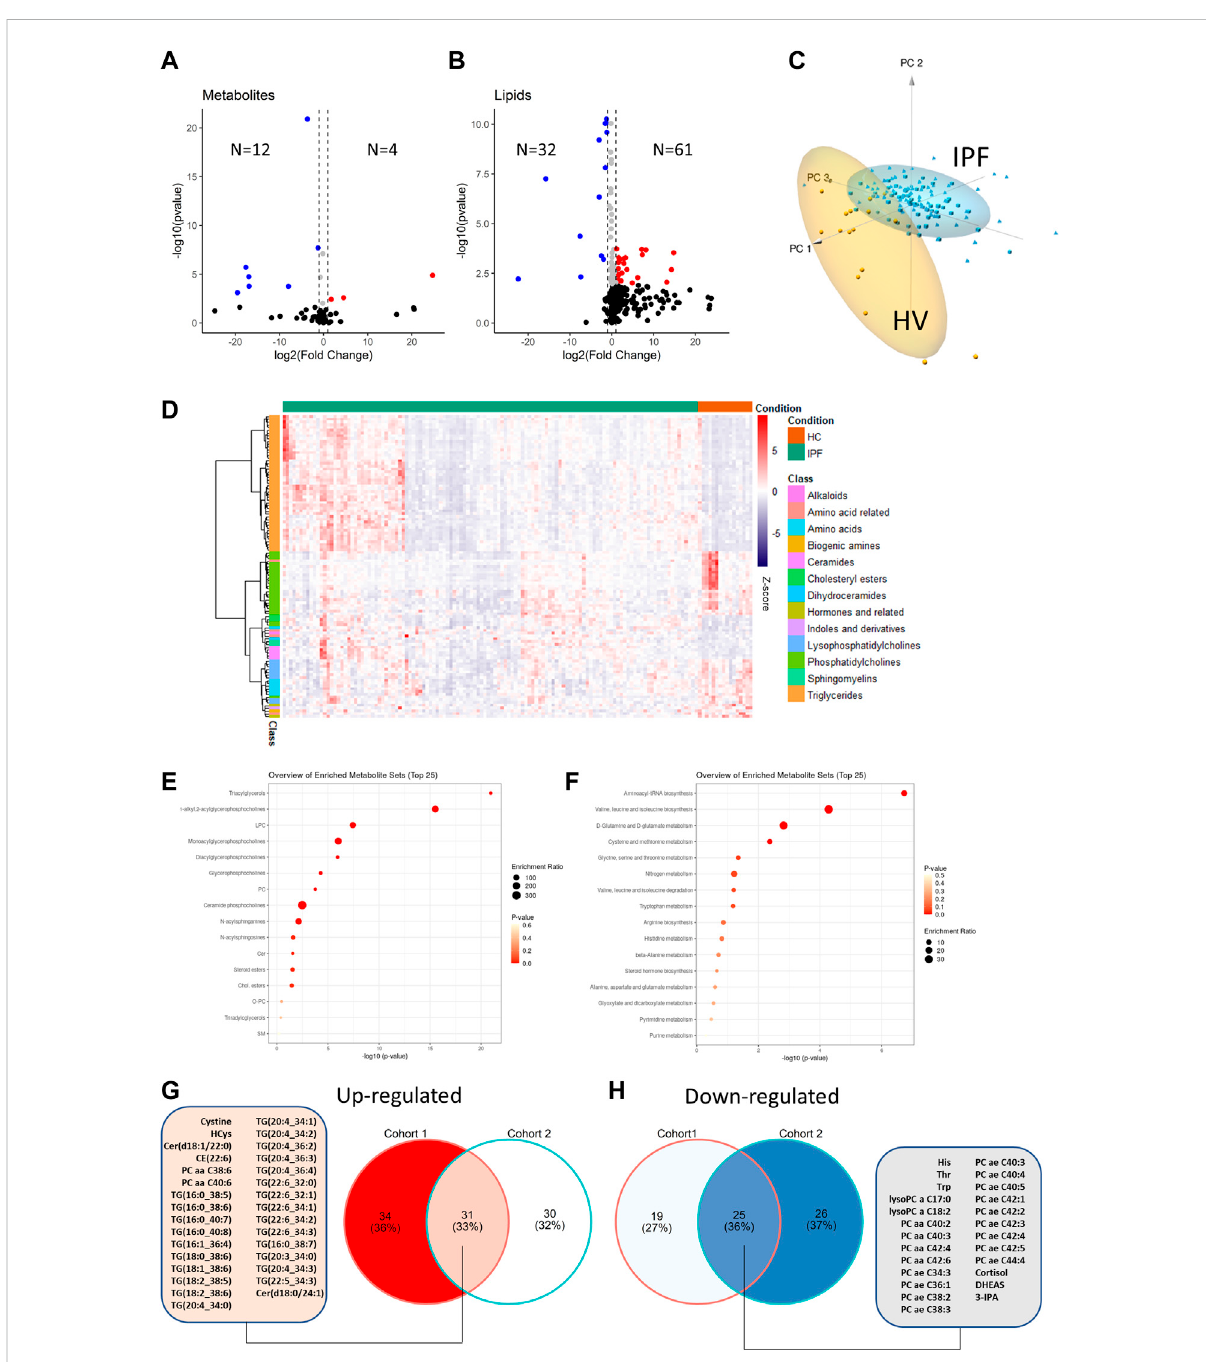
FIGURE 2 Comparison of metabolite differential abundance between patients with idiopathic pulmonary fi brosis and healthy volunteers. Log2-Fold changes were plotted against -log10 ( p -value) of cohort 1 vs. IPF for small molecules (A) and lipids (B) as volcano-plots with numbers of signi fi cantly (FDR < 0.05) up or down-regulated analytes indicated. Deregulated analytes were scaled and plotted as a 3 days principal component analysis with high lighting of IPF vs. healthy volunteers (HV) clusters (C) . De-regulated analytes are plotted as a heatmap with hierarchical clustering of analytes (row-wise) and visualization of abundance by Z-score (D) . KEGG IDs (small molecules) or compound names (lipids) were analyzed for pathway enrichment with resulting enrichment ratios and p -values plotted for small molecule pathways (E) and lipid pathways (F) . The overlap between de-regulated analytes from the IPF cohort 1 and cohort 2 are shown as Venn diagram in (G) and (H) with a list of common de-regulated